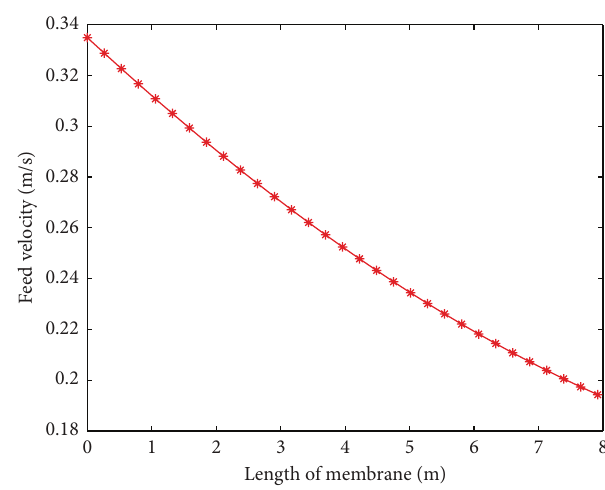
Figure 7: Flow velocity along the length of